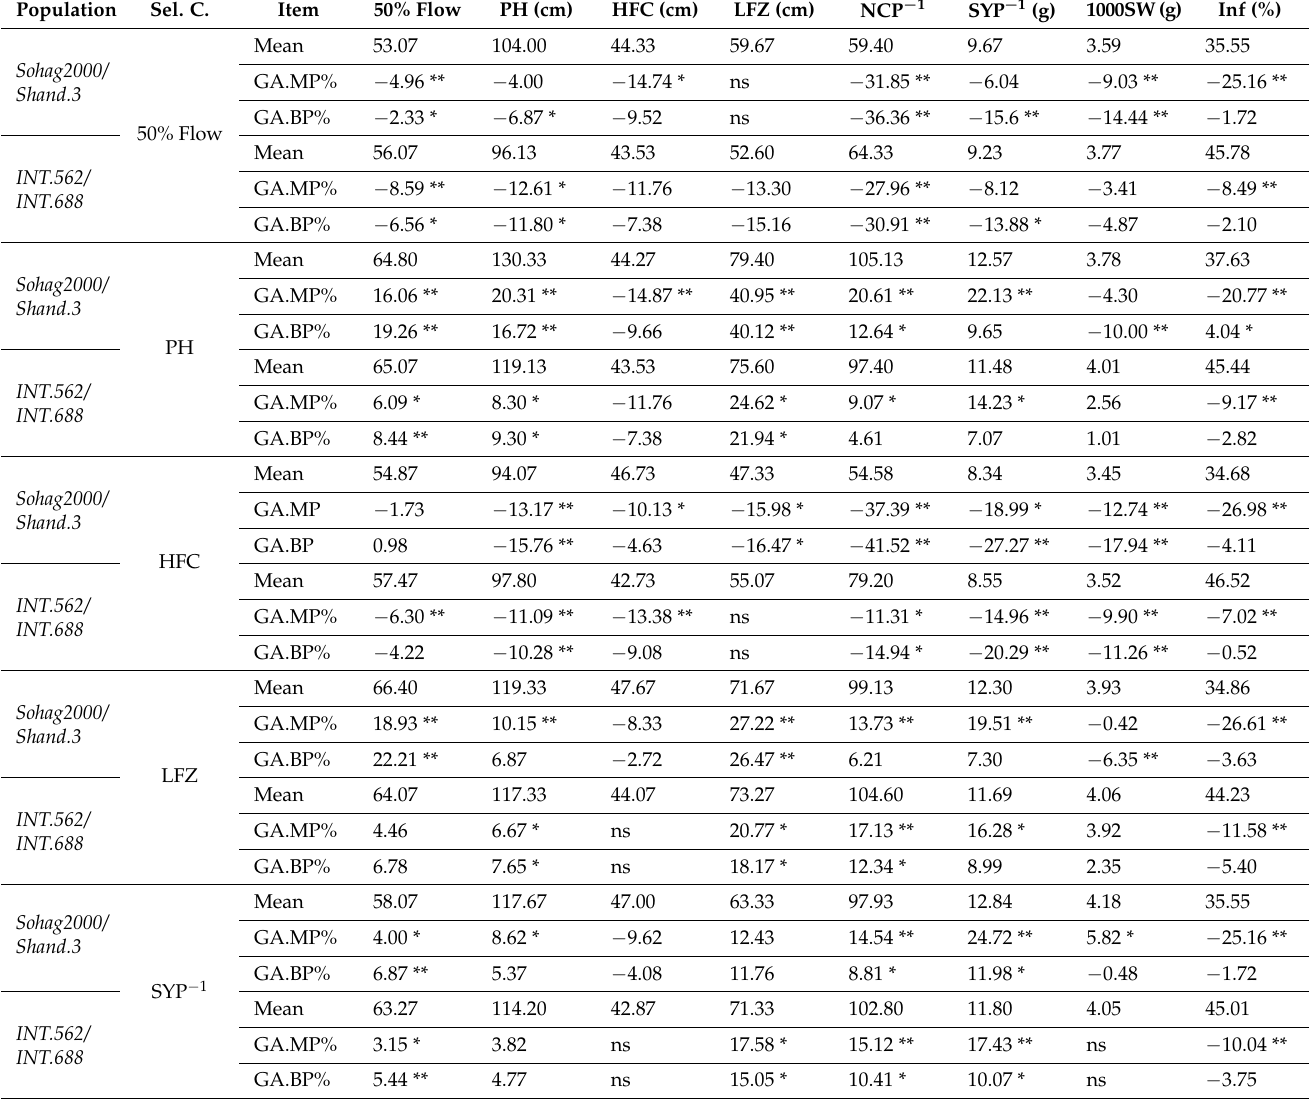
Table 6. The observed genetic advance (GA) in percentage from the mid-parent (GA. MP%) and better parents (GA. BP%) after two cycles of pedigree selection for the two